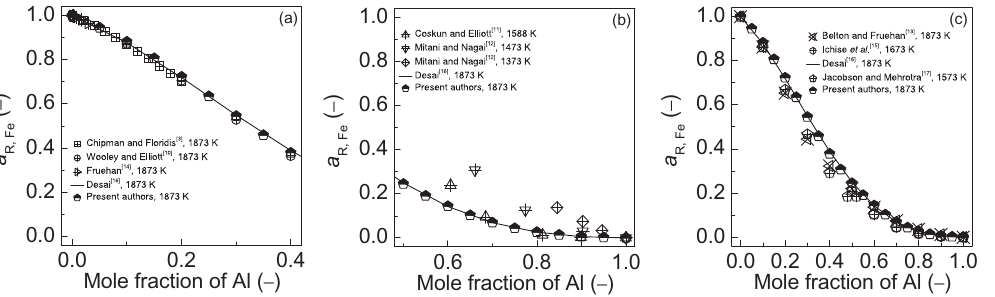
Figure 10: Comparison of reported or obtained results of activity a R,Fe Fe by various researchers with obtained ones by developed AMCT – N i model for three categories of Fe – Al binary melts (a, b, c) with different ranges of mole fraction x Al of Al at various temperatures greater than 1373 K (1100°C),